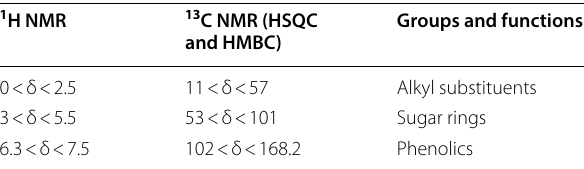
Table 3 1 H and 13 C (HSQC and HMBC) NMR (600 MHz, 298 K) assignments for Fraction